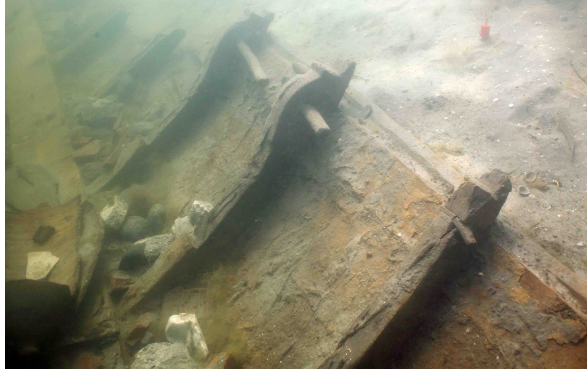
Figure 2. The Phanagorian ship. A detail of the ship’s